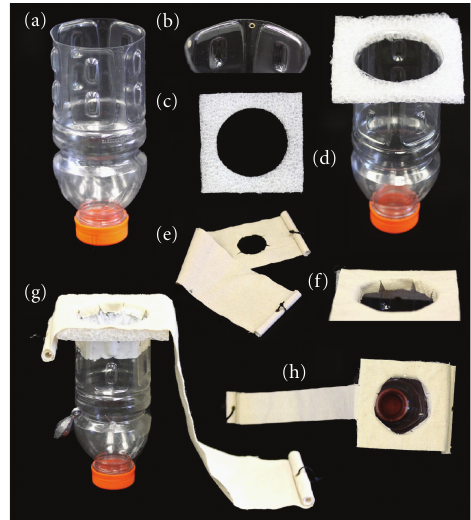
Figure 7: Bottle trap design: (a) inverted 600 mL plastic bottle, (b) hole bored into base of bottle, (c) foam square cut to bottle base, (d) foam square place around bottle base with fishing line tied through holes and around square, (e) canvas strip, with hole, slits around hole, dowels at each end, and zip-ties added, (f) canvas attached to inside of bottle with hot glue (g) fishing weight added to bottle with fishing line, and (h) excess canvas trimmed from foam